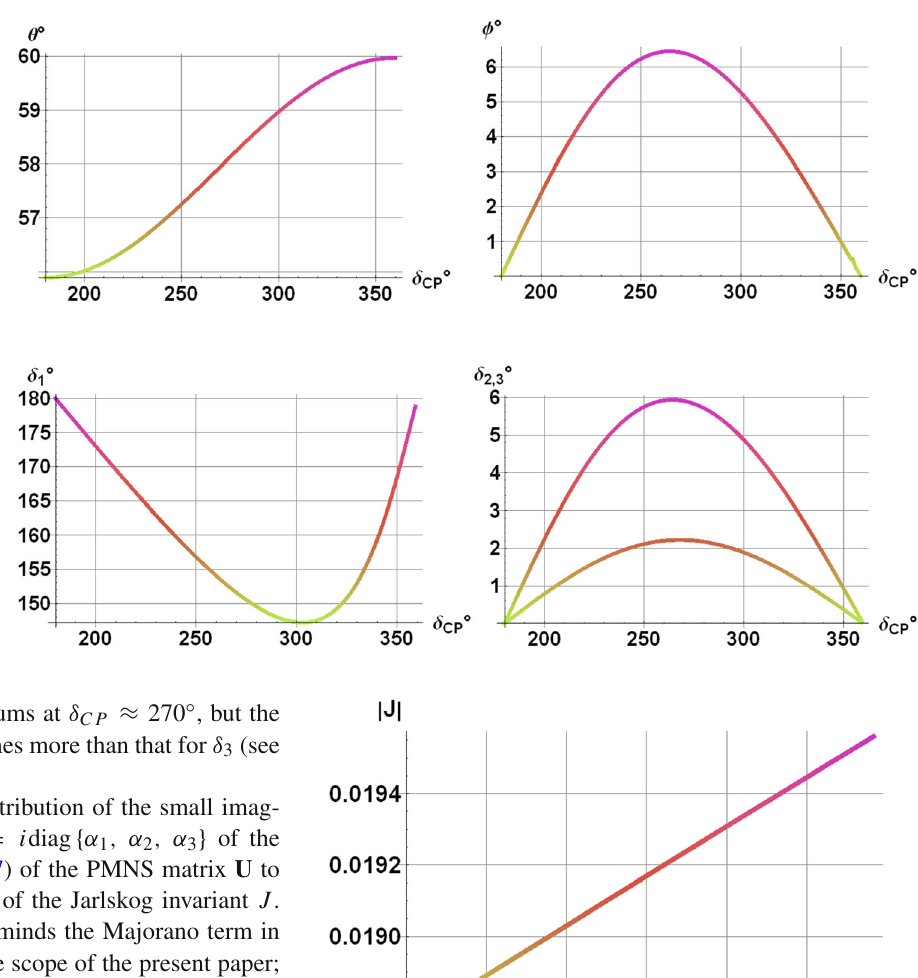
Fig. 7 Dependence of θ(δ CP ) – left plot, ϕ(δ CP ) – right plot